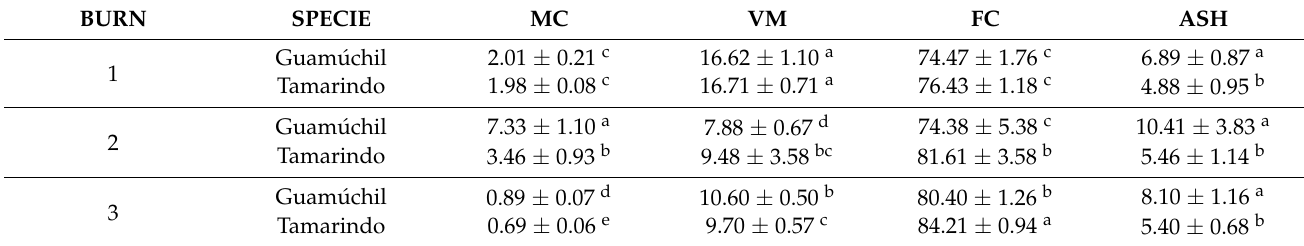
Table 8. Proximate analysis of charcoal produced in modified Brazilian beehive kilns.